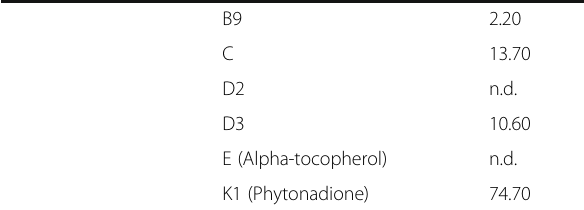
Organic acids profile (mg/g sample)